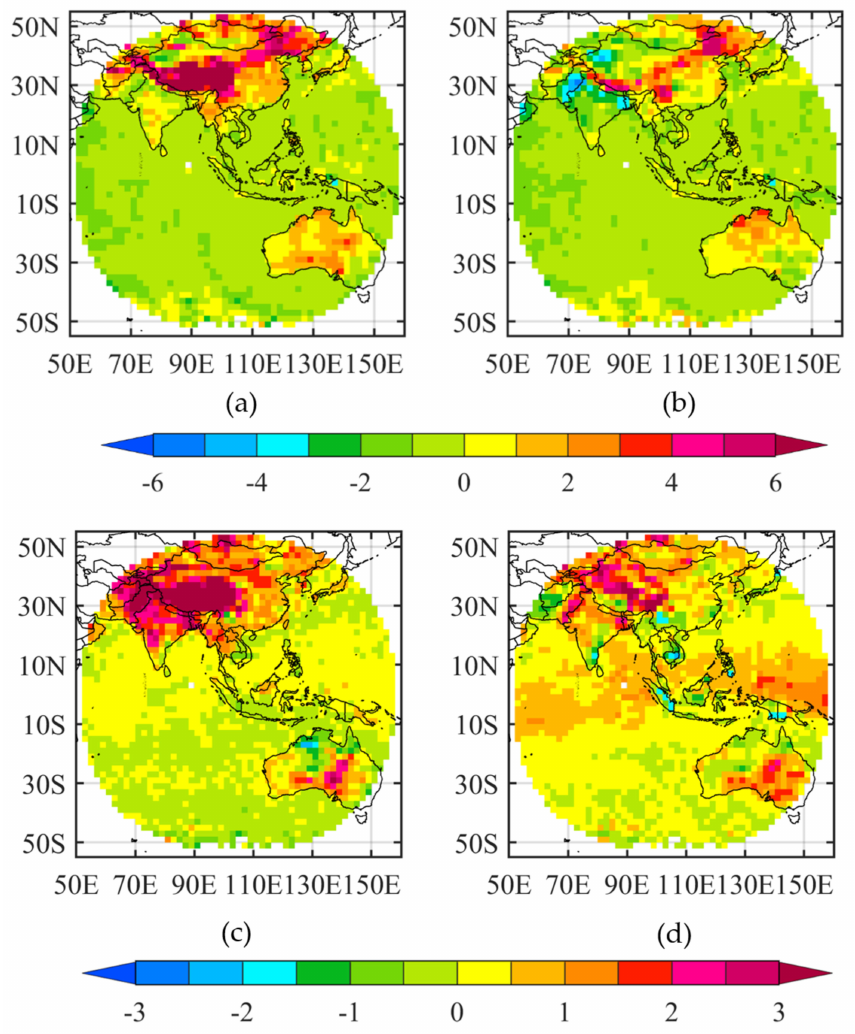
Figure 13. Spatial distributions of ( a ) OMB ERA5 , ( b ) OMB FNL , and ( c ) OMB ERA5 minus OMB FNL for band 11, and ( d ) skin temperature differences between the FNL and ERA5 datasets (FNL minus ERA5) with AGRI observations under clear–sky conditions in January, April, July, and October 2019, within each 2 ◦ × 2 ◦ grid box (Unit: